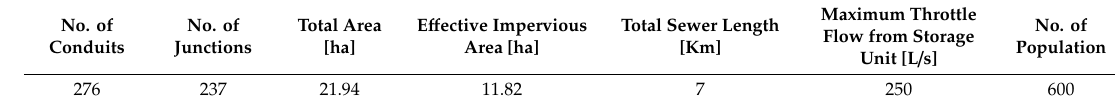
Figure 2. Base (fully looped) stormwater pipe network and layout of the case study. Table 3. Properties of the investigated case study.